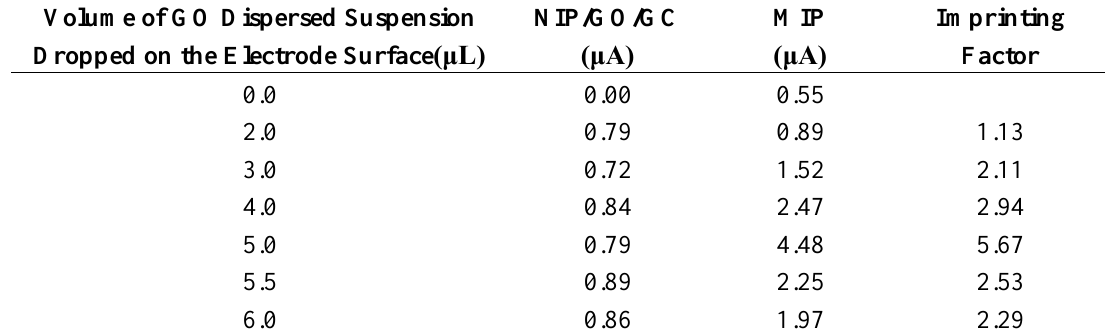
Table 1. Influence of different GO contents on the determination of